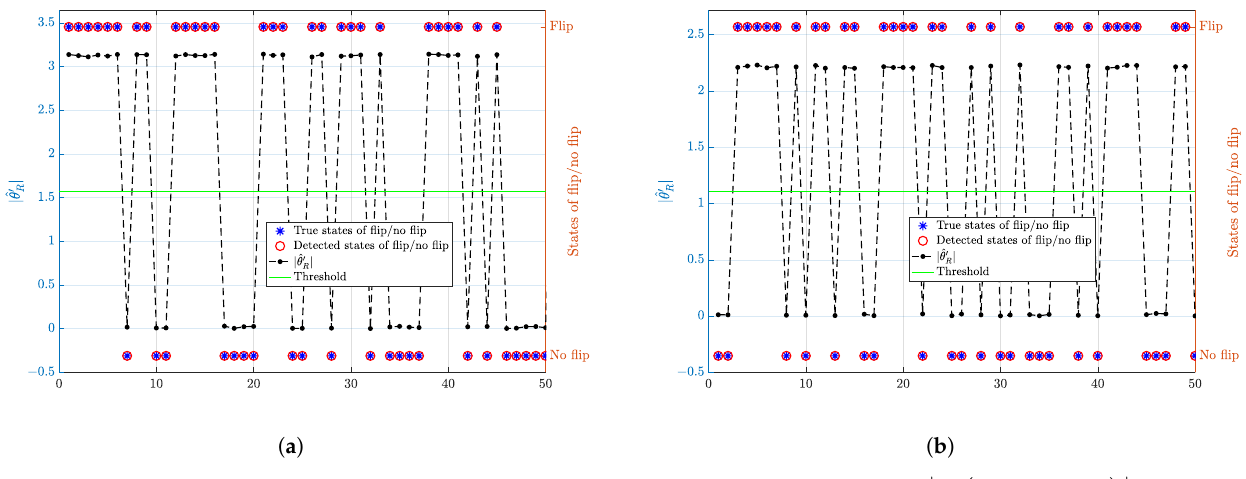
Figure 4. An illustration of the detection of flip/no flip states and the corresponding values of y-axes represent the values of states of flip/no flip with σ = 0.01. ( a ) The number of nodes n = 6, [ ∆ x (cid:48) number of nodes n = 10, [ ∆ x (cid:48)